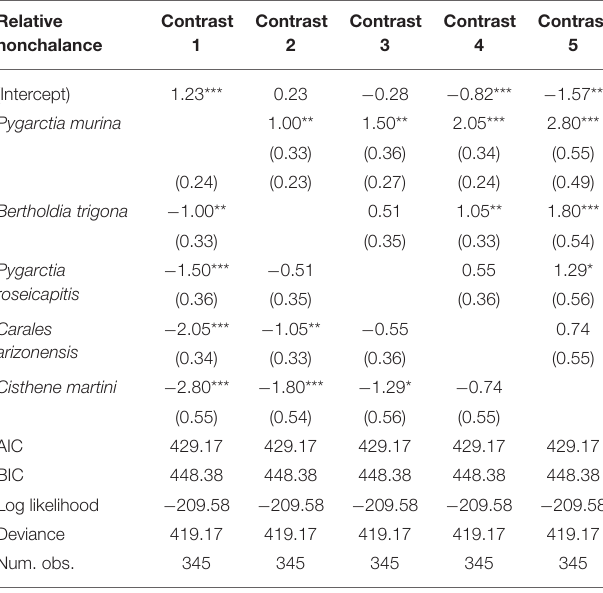
TABLE 2 | Generalized linear model of unpalatability.